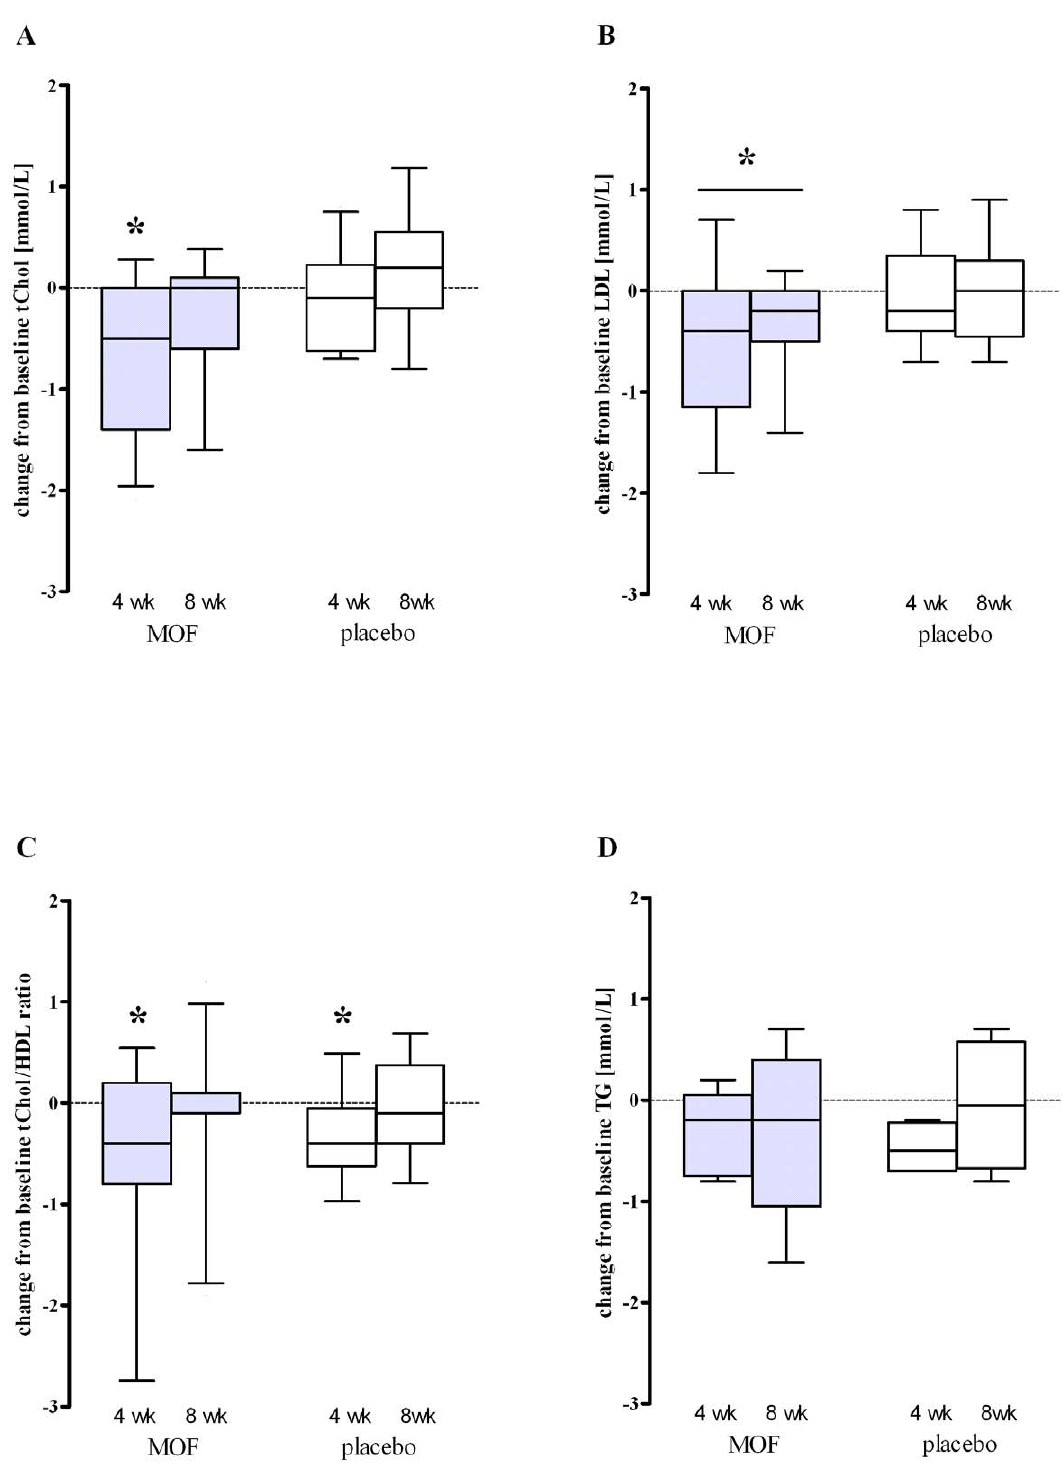
Figure 1. Changes from baseline in median (10 th to 90 th percentile) serum lipid concentrations after 4 and 8 wk supplementation with either 200 mg/d monomeric and oligomeric flavanols (MOF) or placebo: (A) total cholesterol (tChol) concentrations of subjects with tChol baseline concentrations . 5.0 mmol/L (MOF group: n=11, placebo group: n=10); (B) low density lipoprotein (LDL) concentrations of subjects with LDL baseline concentrations . 3.2 mmol/L (MOF group: n=9, placebo group: n=9); (C) ratio of tChol to high density lipoprotein (HDL) of subjects with tChol baseline concentrations . 5.0 mmol/L (MOF group: n=11, placebo group: n=10); (D) triglycerides (TG) concentrations of subjects with TG baseline concentrations . 1.7 mmol/L (MOF group: n=5, placebo group: n=4). Within-group changes were appraised by Wilcoxon Signed Ranks test, between-group changes by Mann-Whitney U test; * Significantly different from baseline in the same group, P , 0.05. There were no significant differences between the MOF and the placebo group at the same time points. doi:10.1371/journal.pone.0028460.g001 PLoS ONE | www.plosone.org